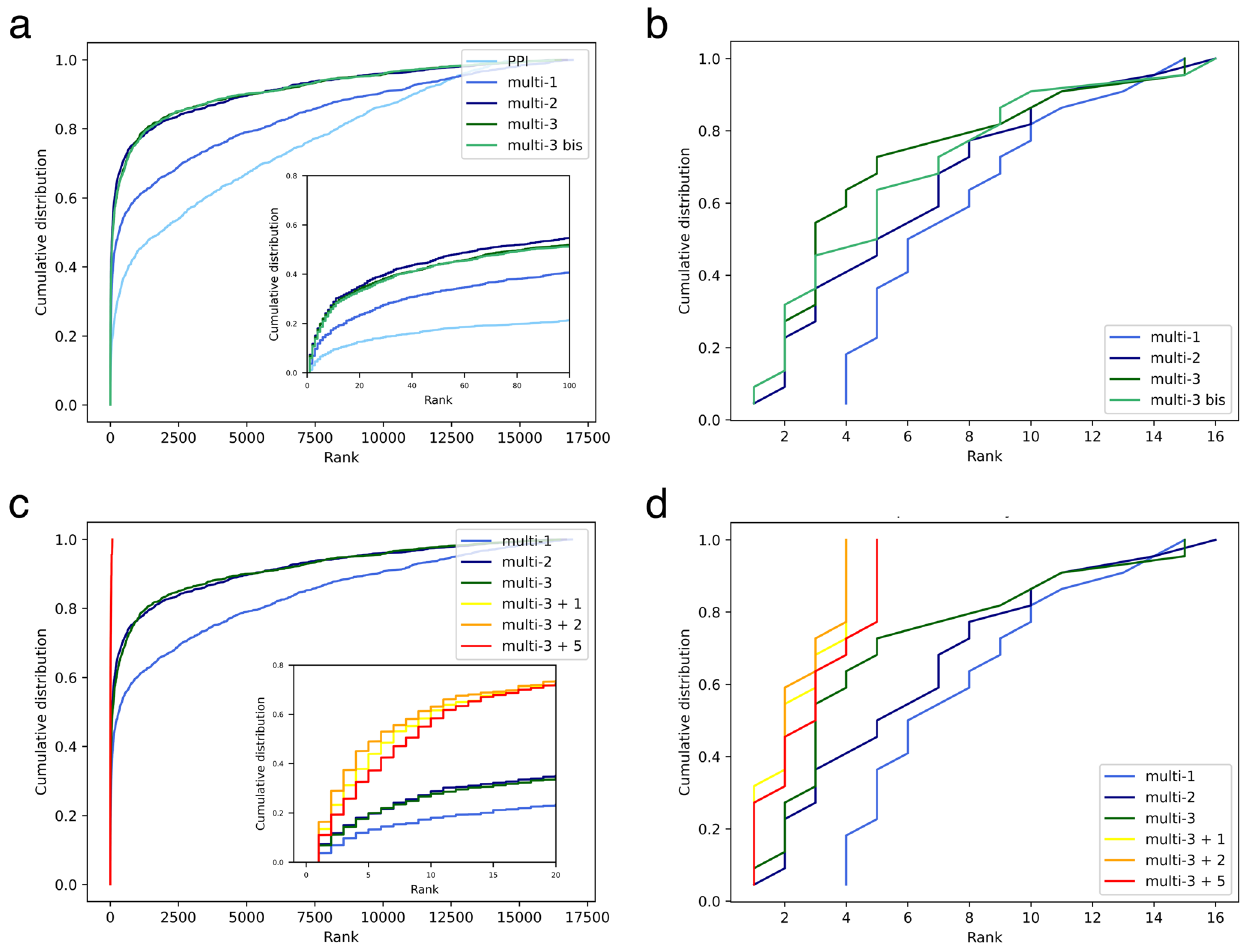
Fig. 3 Evaluation and comparison of multiXrank performances on different combinations of multilayer networks. a , b Cumulative Distribution Functions (CDFs) representing the ranks of the left-out nodes in the Leave-One-Out Cross-Validation (LOOCV) protocol. a : focus on different combinations of biological networks: protein-protein interactions network alone (PPI), gene multiplex network (multi-1), multilayer network composed of the gene multiplex network and the disease monoplex network (multi-2), and multilayer network composed of the gene and drug multiplex networks and the disease monoplex network, for two different sets of parameters (multi-3, multi-3 bis). The multilayer networks are connected by the bipartite networks described in the Evaluations section. b : focus on different combinations of airports networks: French multiplex network (multi-1), multilayer network composed of the French and British airports multiplex networks (multi-2), and multilayer network composed of the French, British, and German airports multiplex networks, for two different sets of parameters (multi-3, multi-3 bis). These multilayer networks are connected by the bipartite networks described in the Evaluations section. c , d CDFs representing the ranks of the left-out nodes in the LOOCV protocol for the multi-3 multilayer networks described previously with arti fi cially increased connectivity in the gene-drug and disease-drug bipartite networks. c The connectivity is arti fi cially increased thanks to the addition of 1 (multi3 + 1), 2 (multi3 + 2) or 5 (multi3 + 5) transit drug nodes for each gene-disease association. d : In the airport multilayer network, the connectivity is arti fi cially increased in the French-German and British-German bipartite networks thanks to the addition of 1 (multi3 + 1), 2 (multi3 + 2) or 5 (multi3 + 5) transit German nodes for each French-British airports association. The parameters of the Random Walk with Restart (RWR) are detailed in Supplementary Tables S5 –